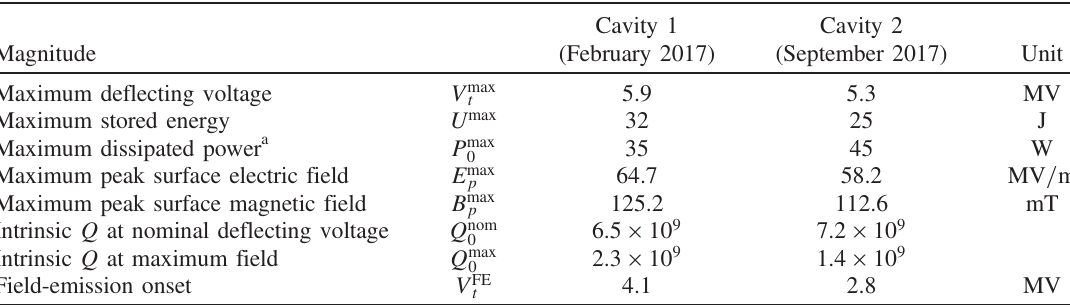
TABLE III. Summary of cavity test